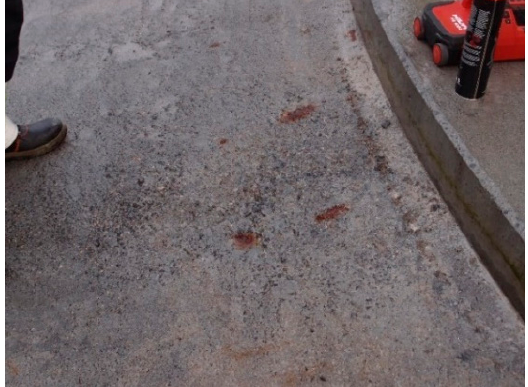
Figure 7. Rust marks observed on the inclined concrete surface of a foundation.